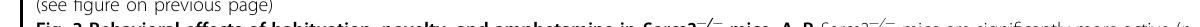
Fig. 3 Behavioral effects of habituation, novelty, and amphetamine in Sorcs2 − / − mice. A , B Sorcs2 − / − mice are signi fi cantly more active ( p < 0.0001, Student ’ s unpaired t -test) and C , D rear signi fi cantly more ( p < 0.003, Student ’ s unpaired t -test) in a novel environment compared to Wt mice. E Wt and Sorcs2 − / − mice show normal activity in their home-cage ( p > 0.4, two-way ANOVA). F Interaction between genotype and amphetamine dose on locomotor activity ( p < 0.05, two-way ANOVA) G but not rearing ( p > 0.2, two-way ANOVA) in habituated mice. H Interaction between genotype and amphetamine dose on locomotor activity ( p < 0.007, two-way ANOVA) I but not rearing ( p > 0.08, two-way ANOVA) in non-habituated mice was observed. In non-habituated mice, a signi fi cant increase in activity was observed in Wt mice when treated with 10 mg/kg compared to the vehicle group, while the activity decreased in Sorcs2 − / − mice ( H , p < 0.03 for both genotypes, Student ’ s unpaired t -test). Data in A , C + F – I are presented as mean activity count/rearing for one hour per mouse ± S.E.M ( n = 48 mice per group for A and C and 12 mice per group for F – I ). Data for B and D are the corresponding data to A and C , respectively, in which activity/rearing is shown over time in 5 min intervals, Data in E are presented as mean activity count for 24 h per day per mouse ± S.E.M ( n = 8 mice per group). Above the graph, it is stated if the mice were habituated or not to the test-cage prior to drug treatment. Asterisk indicates a signi fi cant difference between genotypes, while # and § indicate signi fi cant differences between the treated group and vehicle group within Wt and Sorcs2 − / − mice, respectively. *, # and § p < 0.05; **, ## and §§ p < 0.01; *** and §§§ p < 0.001; ****, #### and §§§§ p <